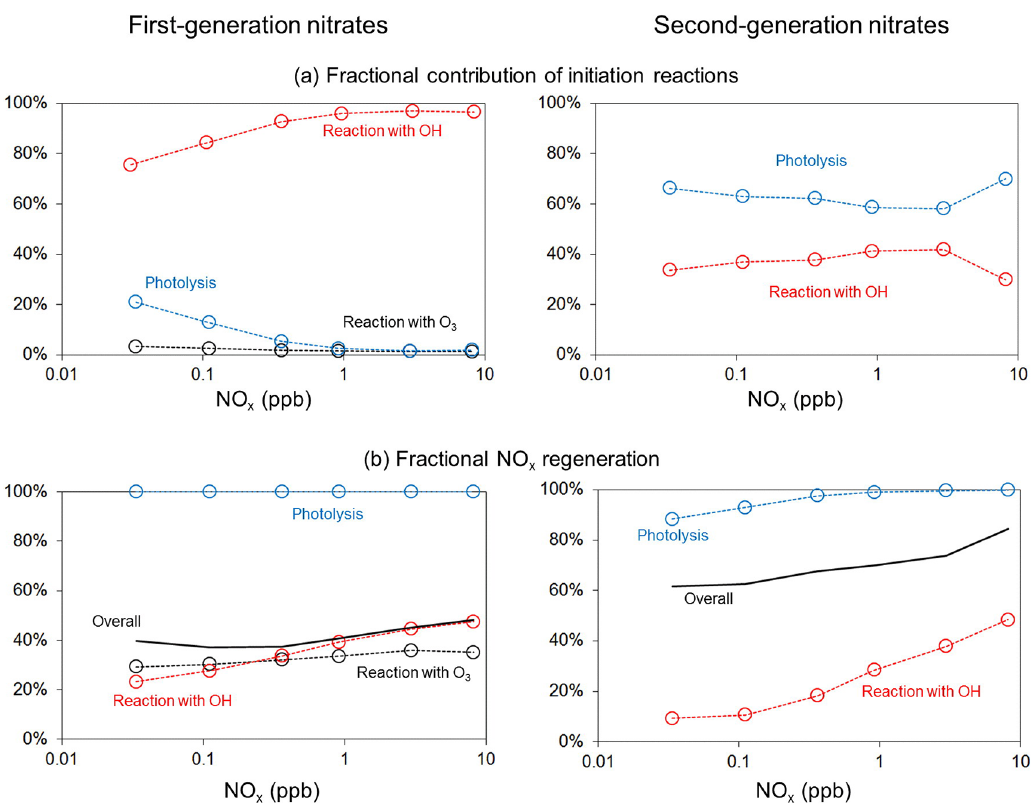
Figure 13. (a) Comparison of the fractional contributions of the initiation reactions contributing to the removal of first- and second-generation organic nitrates in the MCM v3.3.1 simulations. (b) The fractional regeneration of NO x resulting from each of the initiation reactions for first- and second-generation organic nitrates and the overall fractional NO x regeneration in each